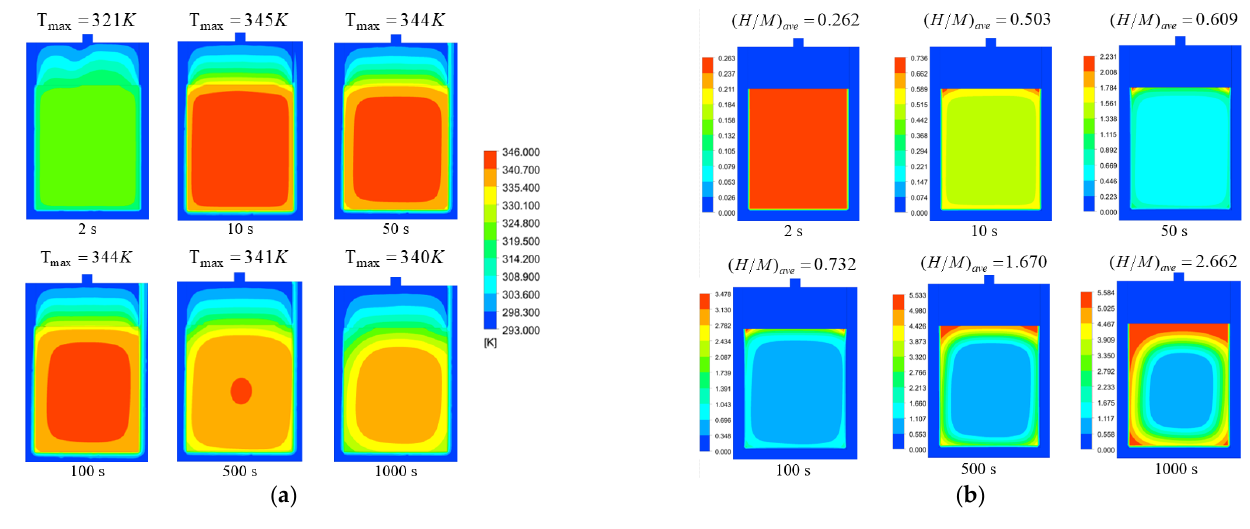
Figure 8. Temperature and hydrogen storage capacity distribution at different times of the reaction tank subjected to an oil coolant flow rate of 0.005 m/s. ( a ) Temperature distribution cloud chart; ( b ) Hydrogen storage capacity distribution cloud chart.